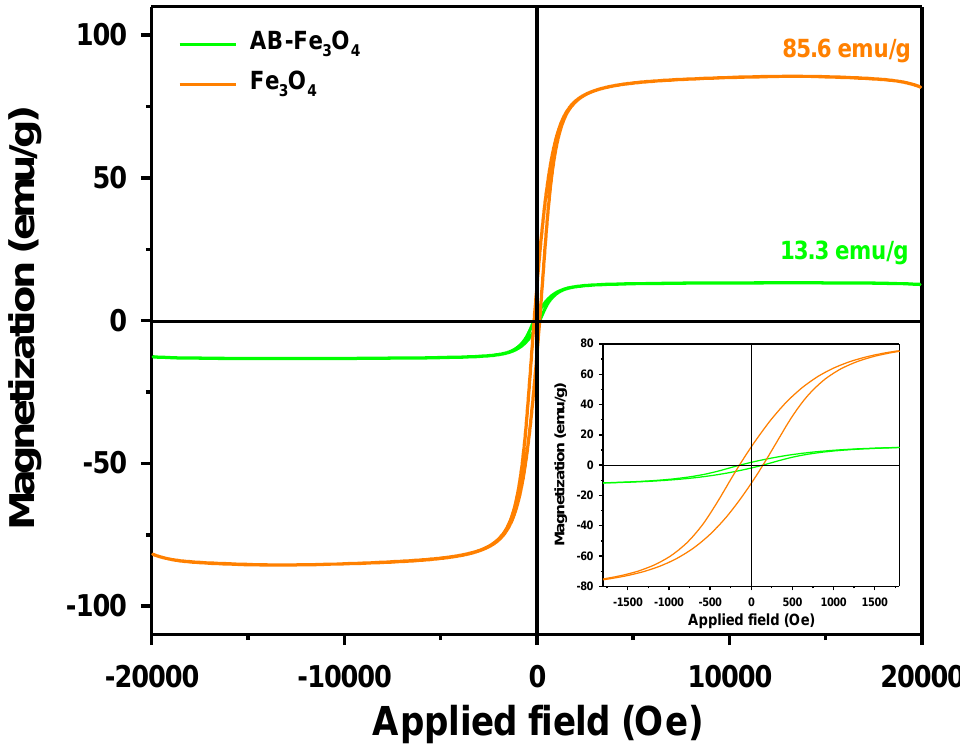
Figure 5. Room temperature magnetic hysteresis loops of Fe 3 O 4 and AB-Fe 3 O 4 . Table 2. Textural characteristics of AB, Fe 3 O 4 , and AB-Fe 3 O 4